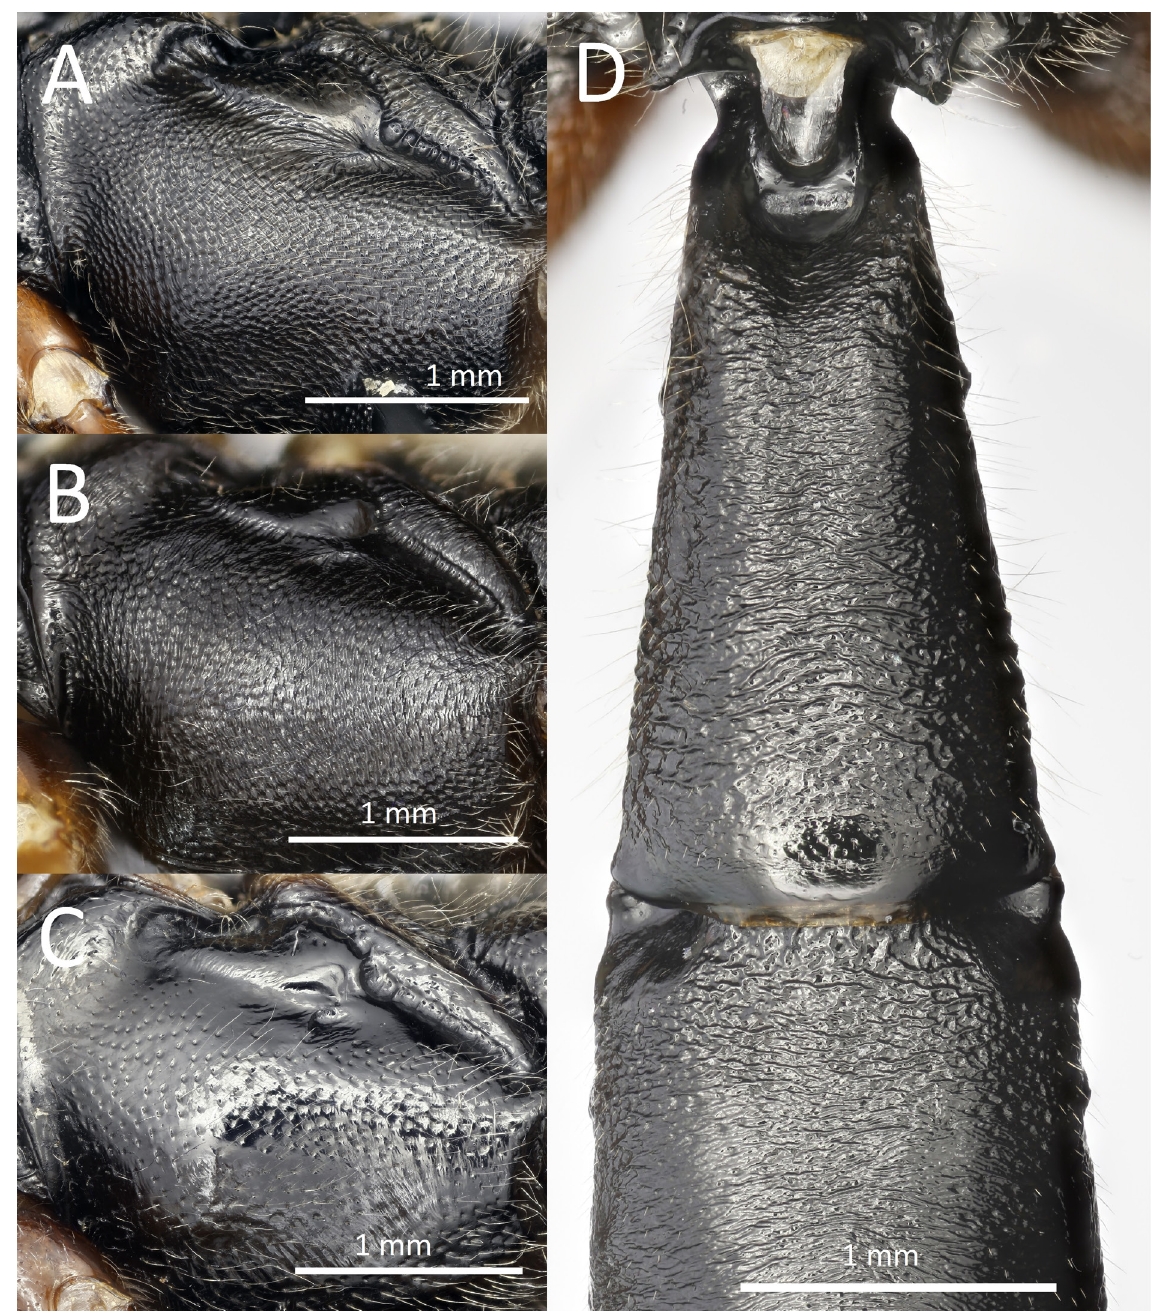
Fig. 4. A . Neoxorides opacus (Kokujev, 1903) stat. rev., ♀ (NJ), mesopleuron, lateral view. B . N. collaris (Gravenhorst, 1829), ♀ (NJ), mesopleuron, lateral view. C . N. nitens (Gravenhorst, 1829), ♀ (NJ), mesopleuron, lateral view. D . N. opacus , ♀ (NJ), basal portion of metasoma, dorsal view. Photos: Alexander